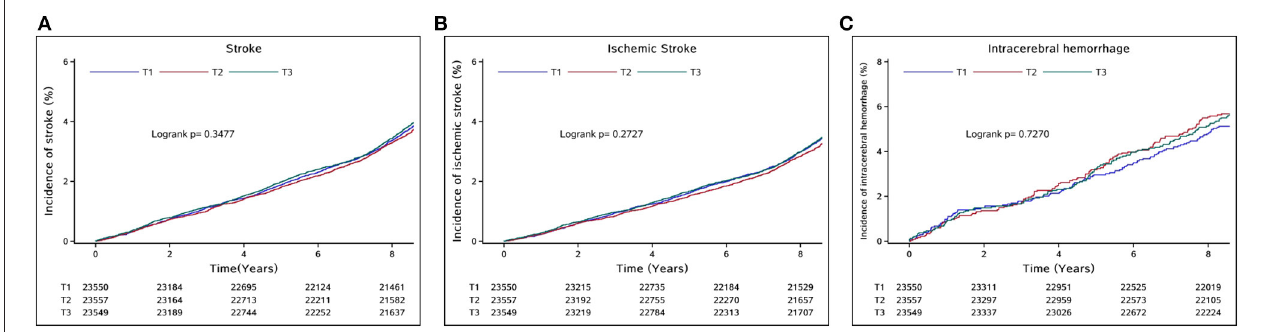
FIGURE 2 | Cumulative incidences of (A) total stroke, (B) ischemic stroke, and (C) intracerebral hemorrhage according to the tertile of 2-year TC change.